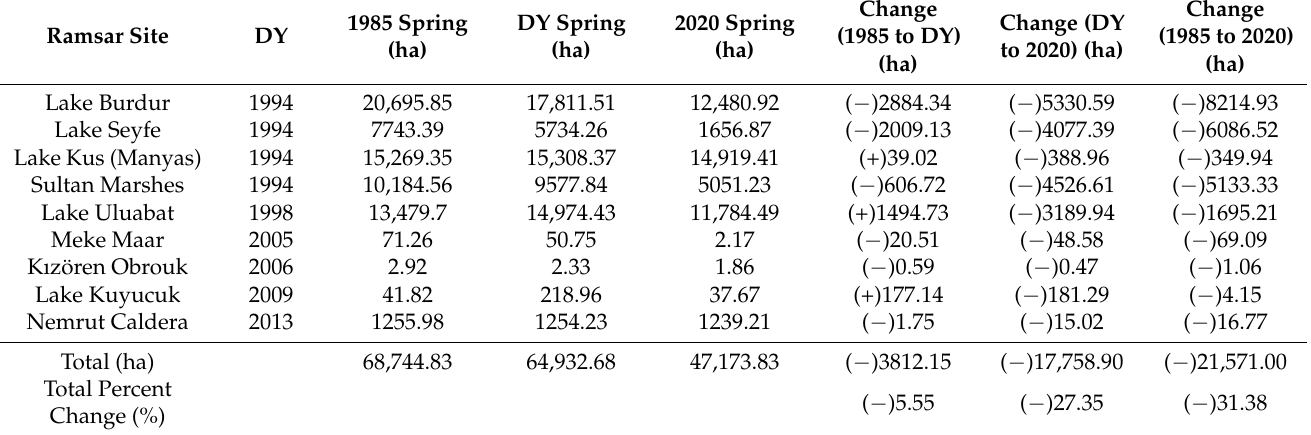
Table 7. The surface water areas of Ramsar sites in spring (1985, designation year (DY), and year 2020) and the changes.